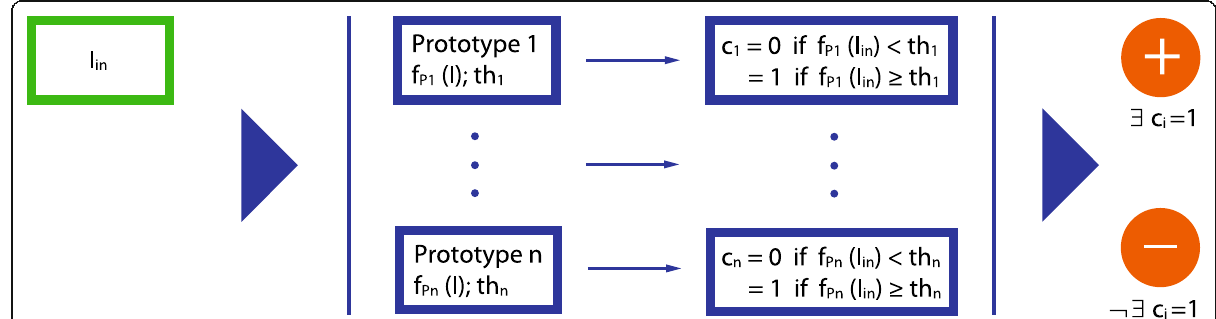
Fig. 6 Schematic representation of the classifier of a category (Fig. 5). I in : any image to be classified. n : number of prototypes of the LadeCA word. f